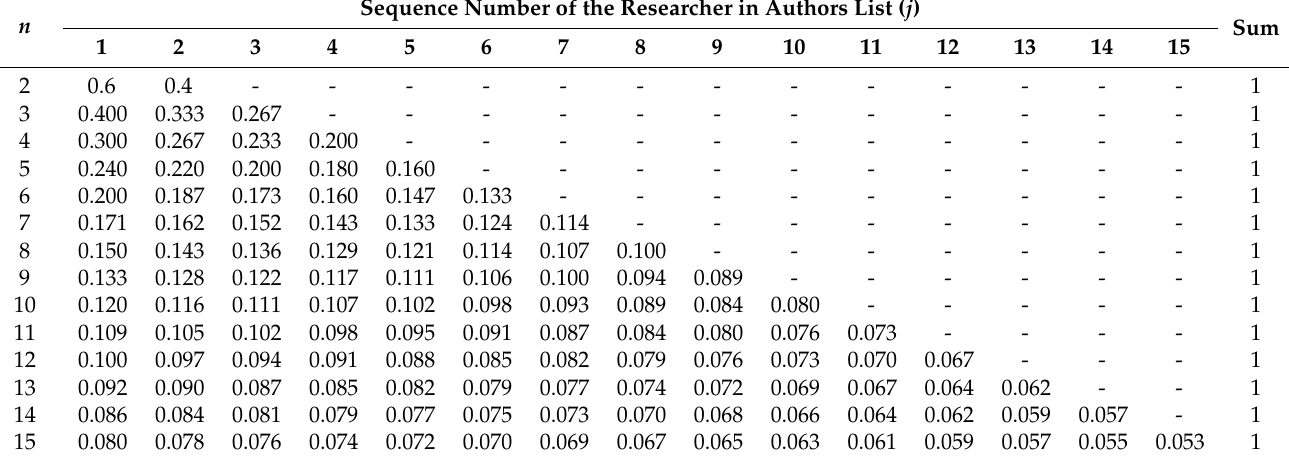
Table 2. Uniformly decreasing distribution of fractional credit shares of a publication among the coauthors (2 to 15). k =